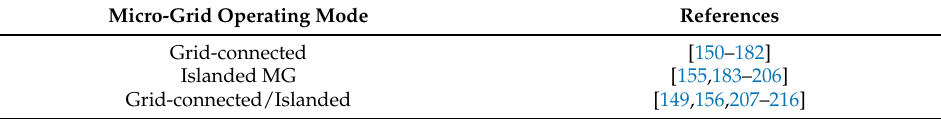
Table 4. Modes of MG